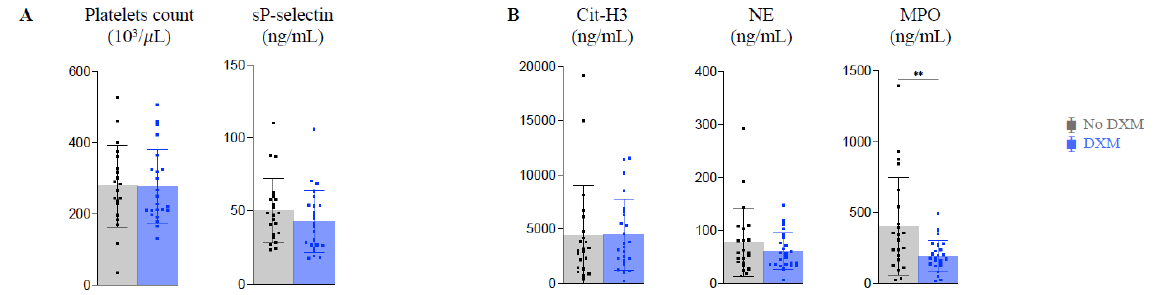
Figure 2. Corticosteroid effects on platelet activation ( A ) and NETosis ( B ) in critical COVID-19 patients. Scatter graphs of soluble biomarkers of platelet activation and NETosis. Individual values (dots), mean (colored rectangle), and standard deviation are presented on the graphs. ** p < 0.01 between the no DXM group and the DXM group. sP-selectin, soluble p-selectin; Cit-H3, citrullinated histone 3; MPO, myeloperoxidase; NE, neutrophil elastase.